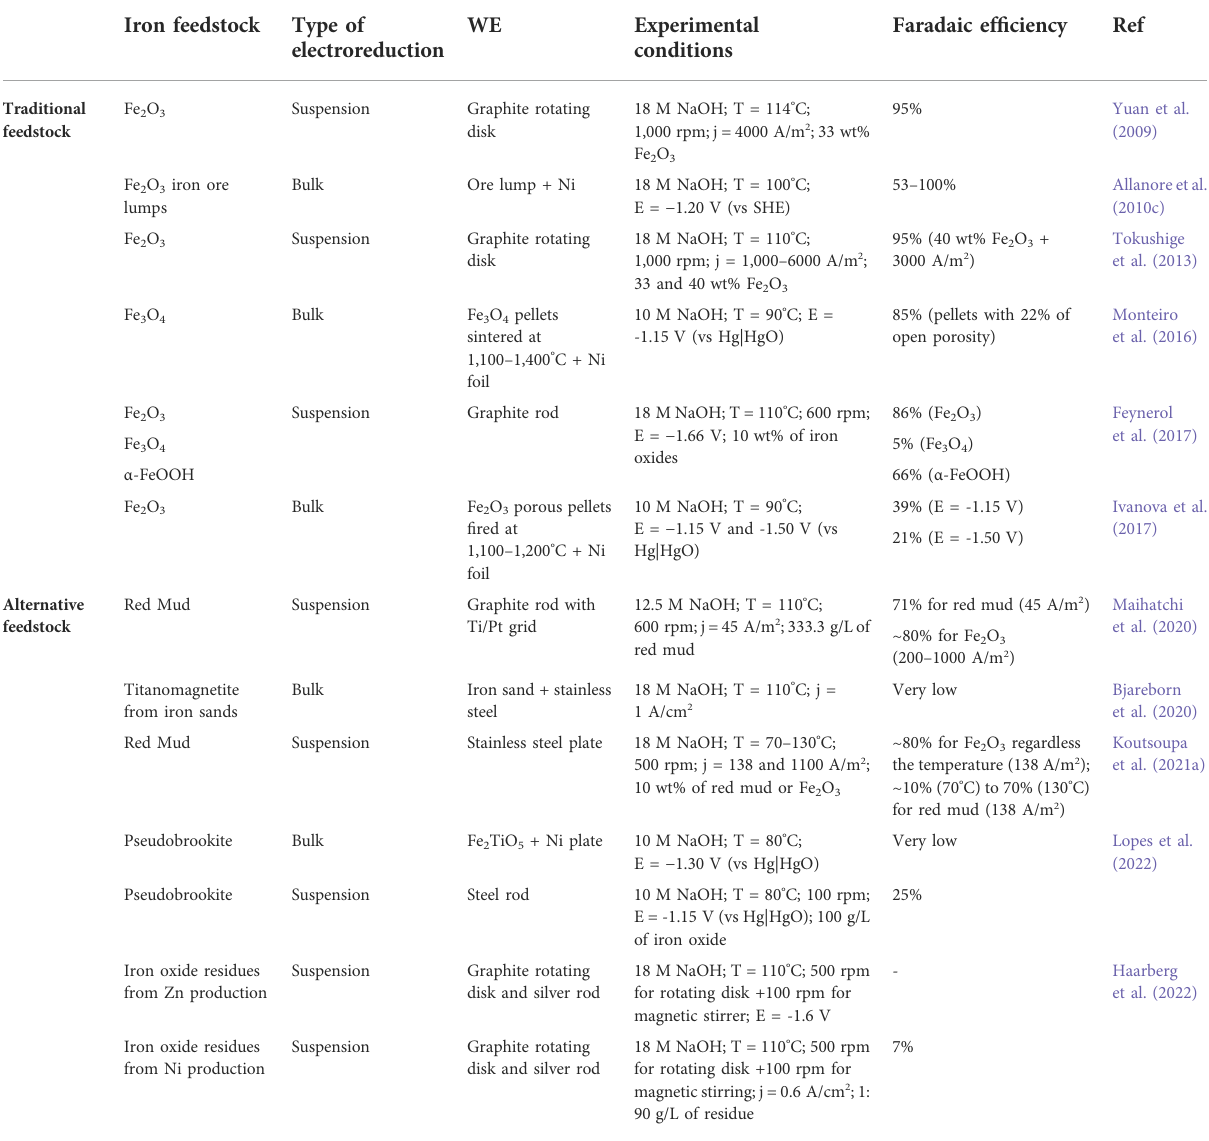
TABLE 1 Comparison of the Faradaic Ef fi ciencies between traditional and alternative iron oxide